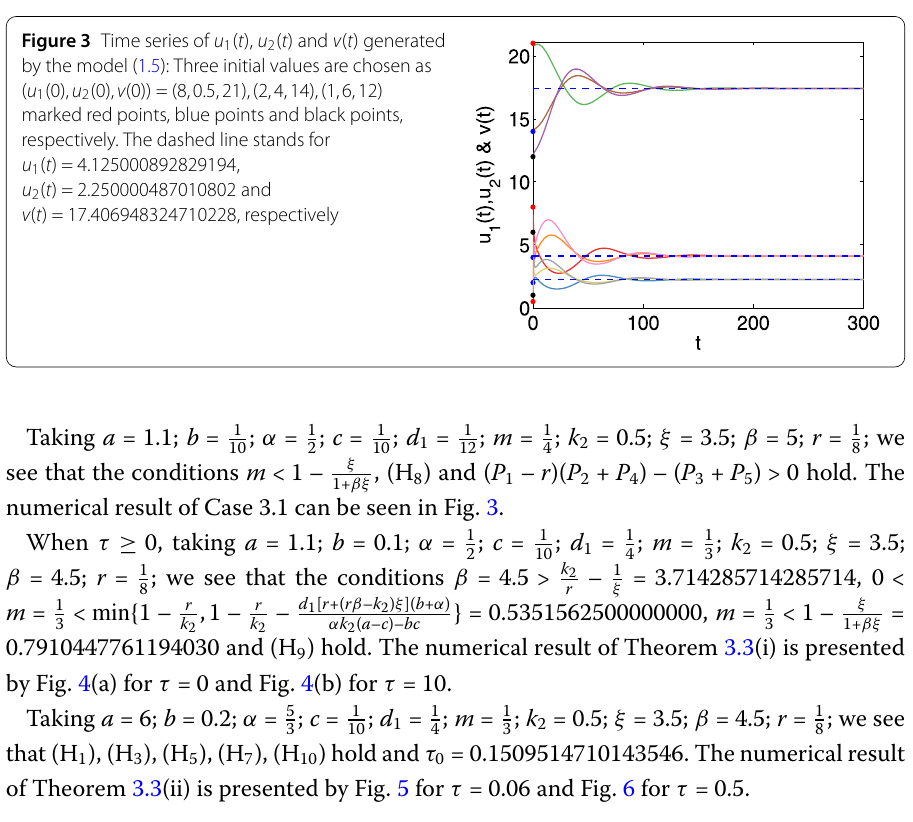
Figure 3 Time series of u 1 ( t ), u 2 ( t ) and v ( t ) generated by the model (1.5): Three initial values are chosen as ( u 1 (0), u 2 (0), v (0)) = (8,0.5,21),(2,4,14),(1,6,12) marked red points, blue points and black points, respectively. The dashed line stands for u 1 ( t ) = 4.125000892829194, u 2 ( t ) = 2.250000487010802 and v ( t ) = 17.406948324710228, respectively